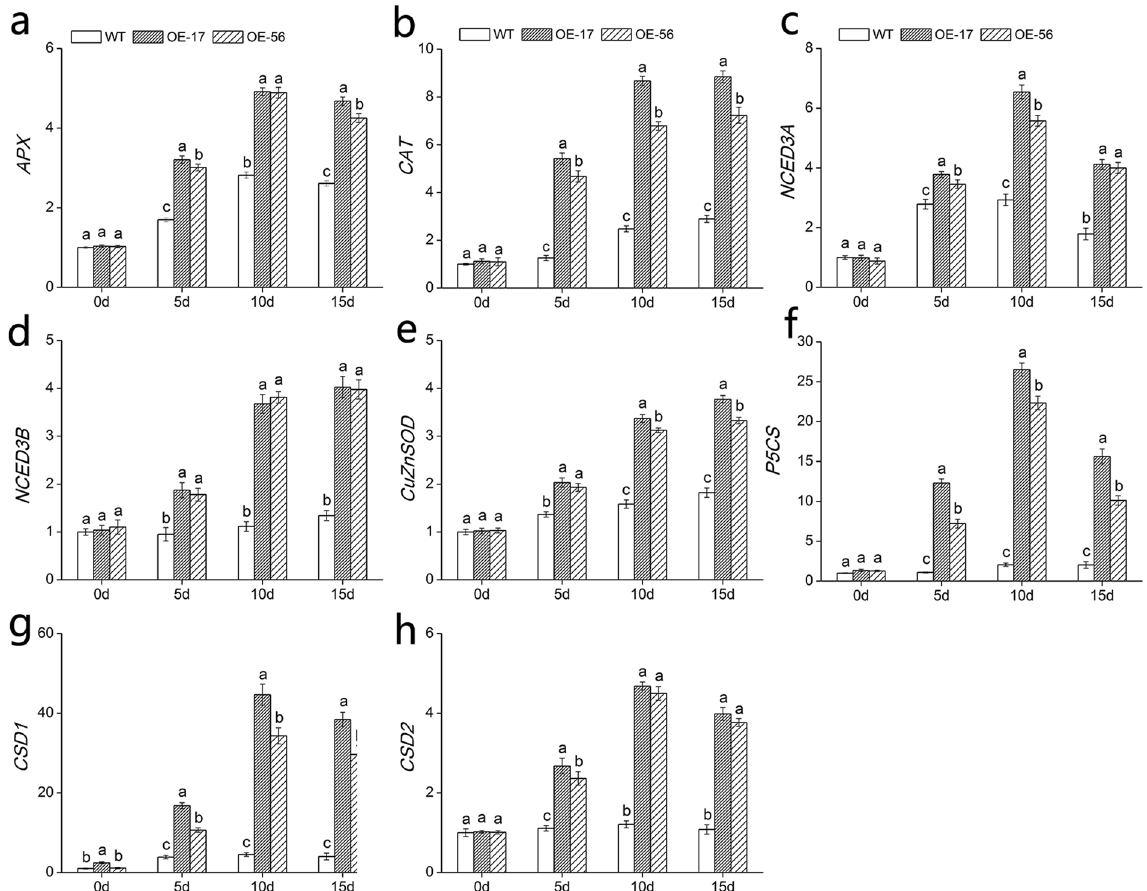
Figure 6. Expression of stress responsive genes in WT and DgWRKY5 transgenic lines (OE-17 and OE-56) at various time points (0, 1, 5, 10 and 15d). EF1a was amplified as a control. Data represent means and standard errors of three replicates. Different letters above columns indicate (P < 0.05) differences between